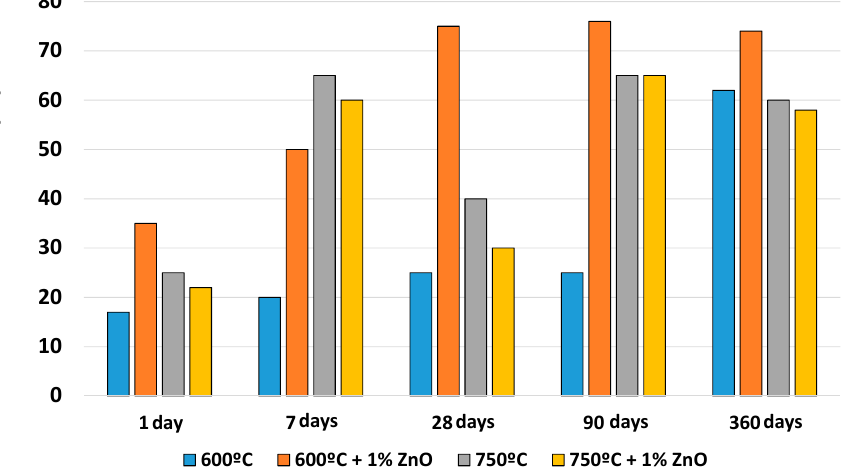
Figure 5. Fixed lime evolution with different activation conditions.